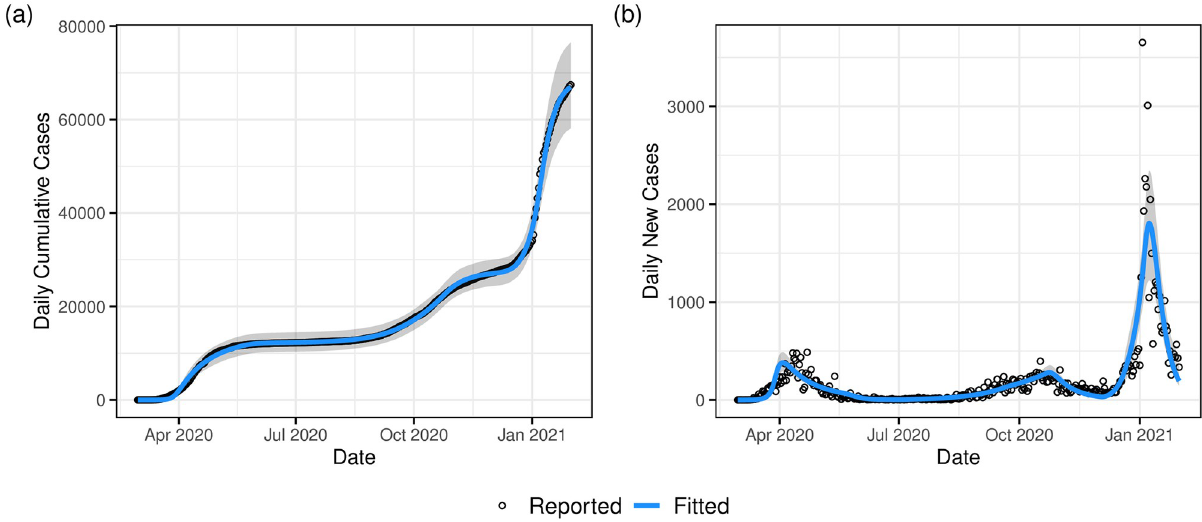
Fig 4. Model fit to daily recorded cases with bootstrapped 95% uncertainty